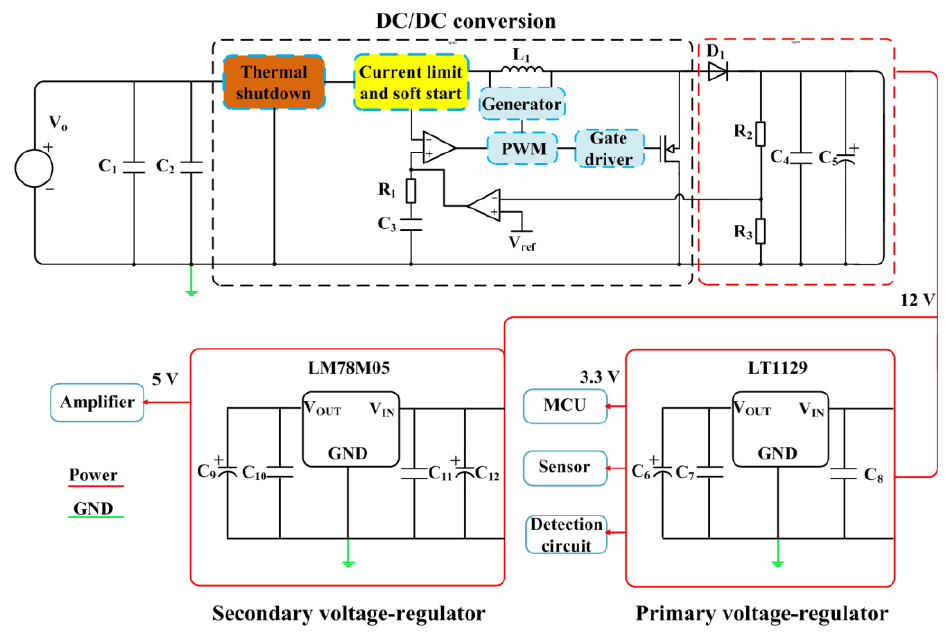
Figure 13. The DC / DC conversion circuit and power supply circuit. Figure 13. The DC/DC conversion circuit and power supply circuit.